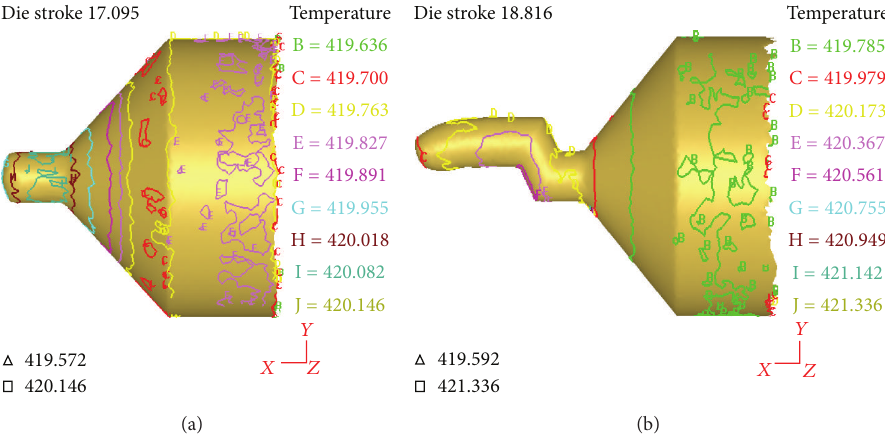
Figure 4: Temperature contours in the billet extruded at a ram speed of 2 mm/s and at the displacements of (a) 17.095 mm and (b)